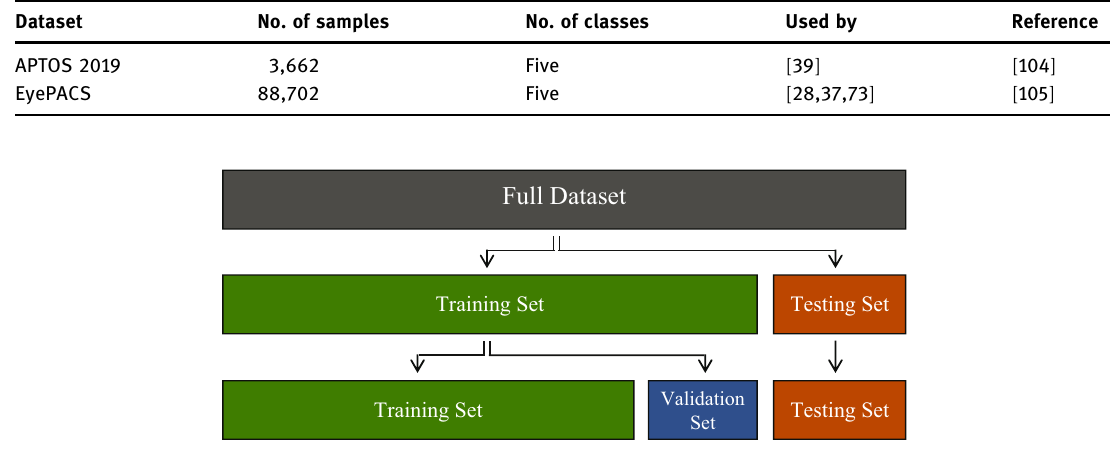
Table 8: Datasets for diabetic retinopathy